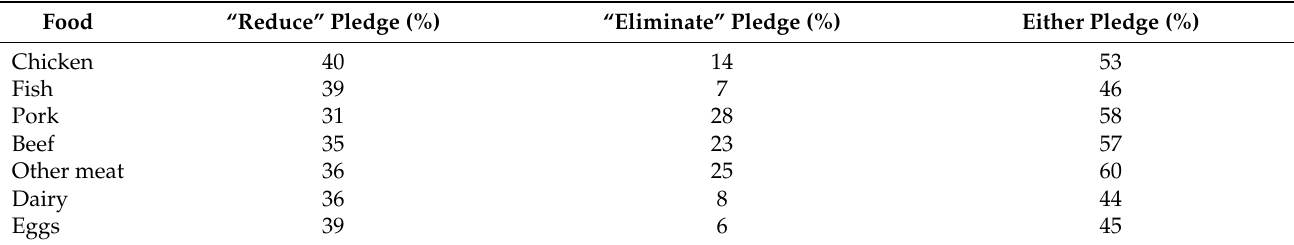
Table 6. For Study 3, the percent of intervention-group participants ( n = 333) who pledged to reduce consumption, who pledged to eliminate consumption, and who made either pledge for each food